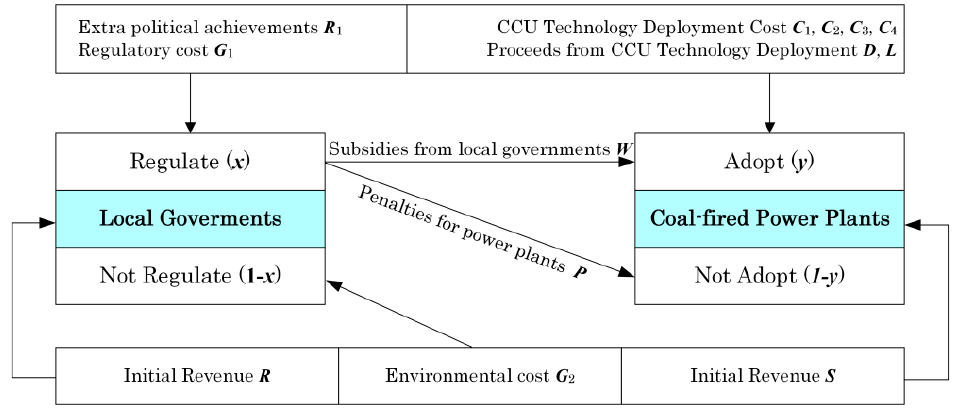
Figure 5. Behavioral strategy framework considering local governments and power plants (Nie